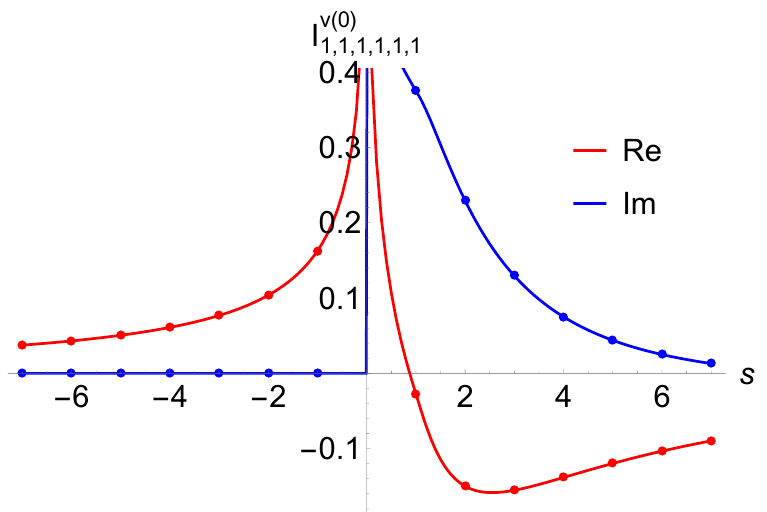
. The solid points represent values computed 1 , 1 , 1 , 1 , 1 , 1